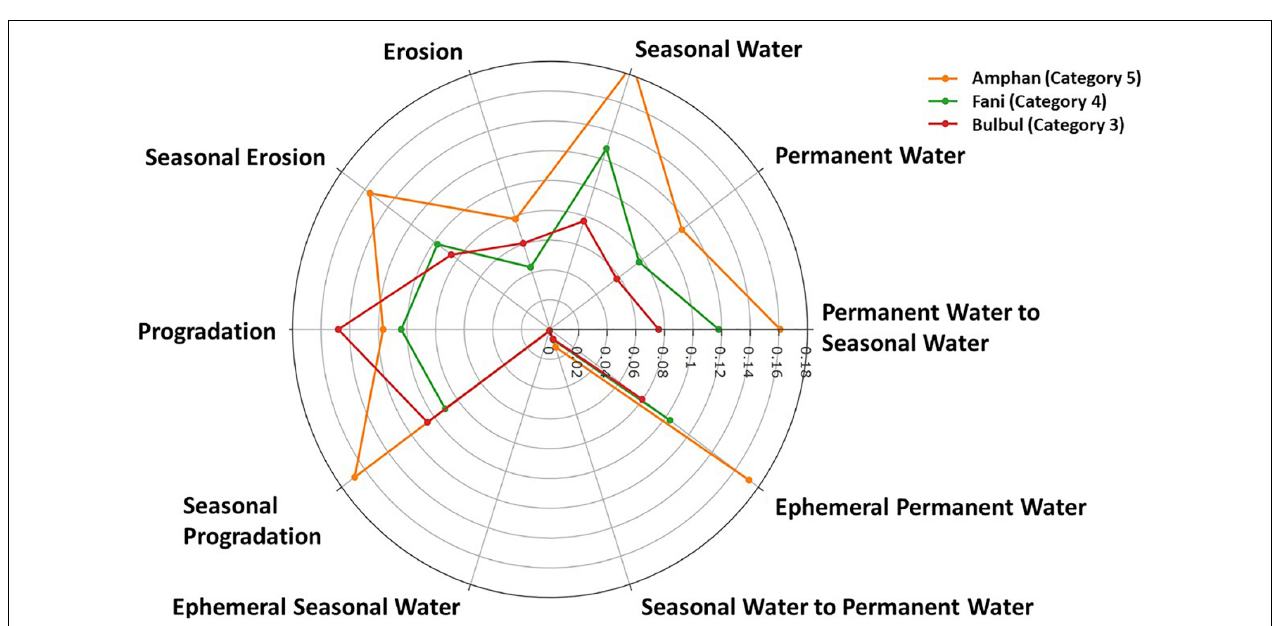
FIGURE 6 | Loss of different shoreline classes due to Cyclone Amphan (Orange), Cyclone Bulbul (Red), and Cyclone Fani